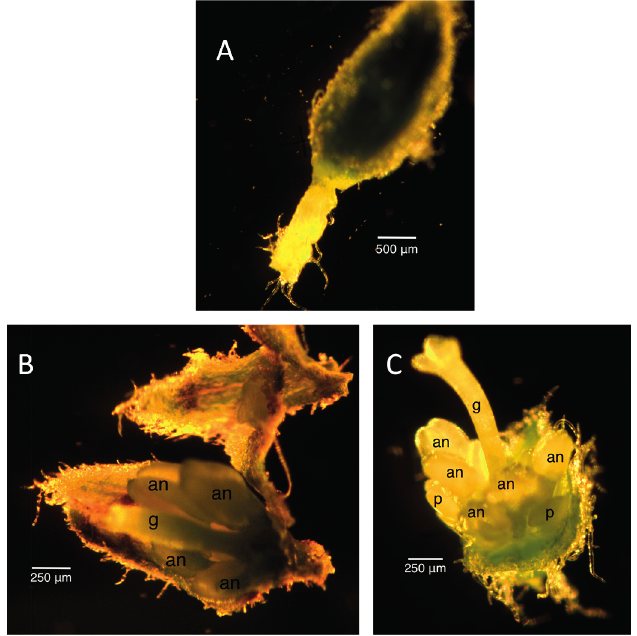
Figure 10. Unusual floral bud morphologies. ( A ) Segmented pedicel with buds